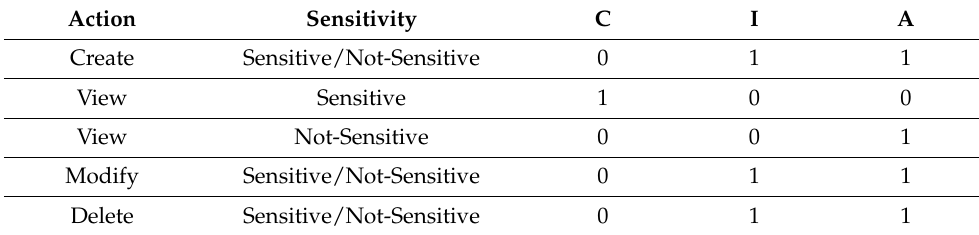
Table 7. Risk values associated with action and data sensitivity.